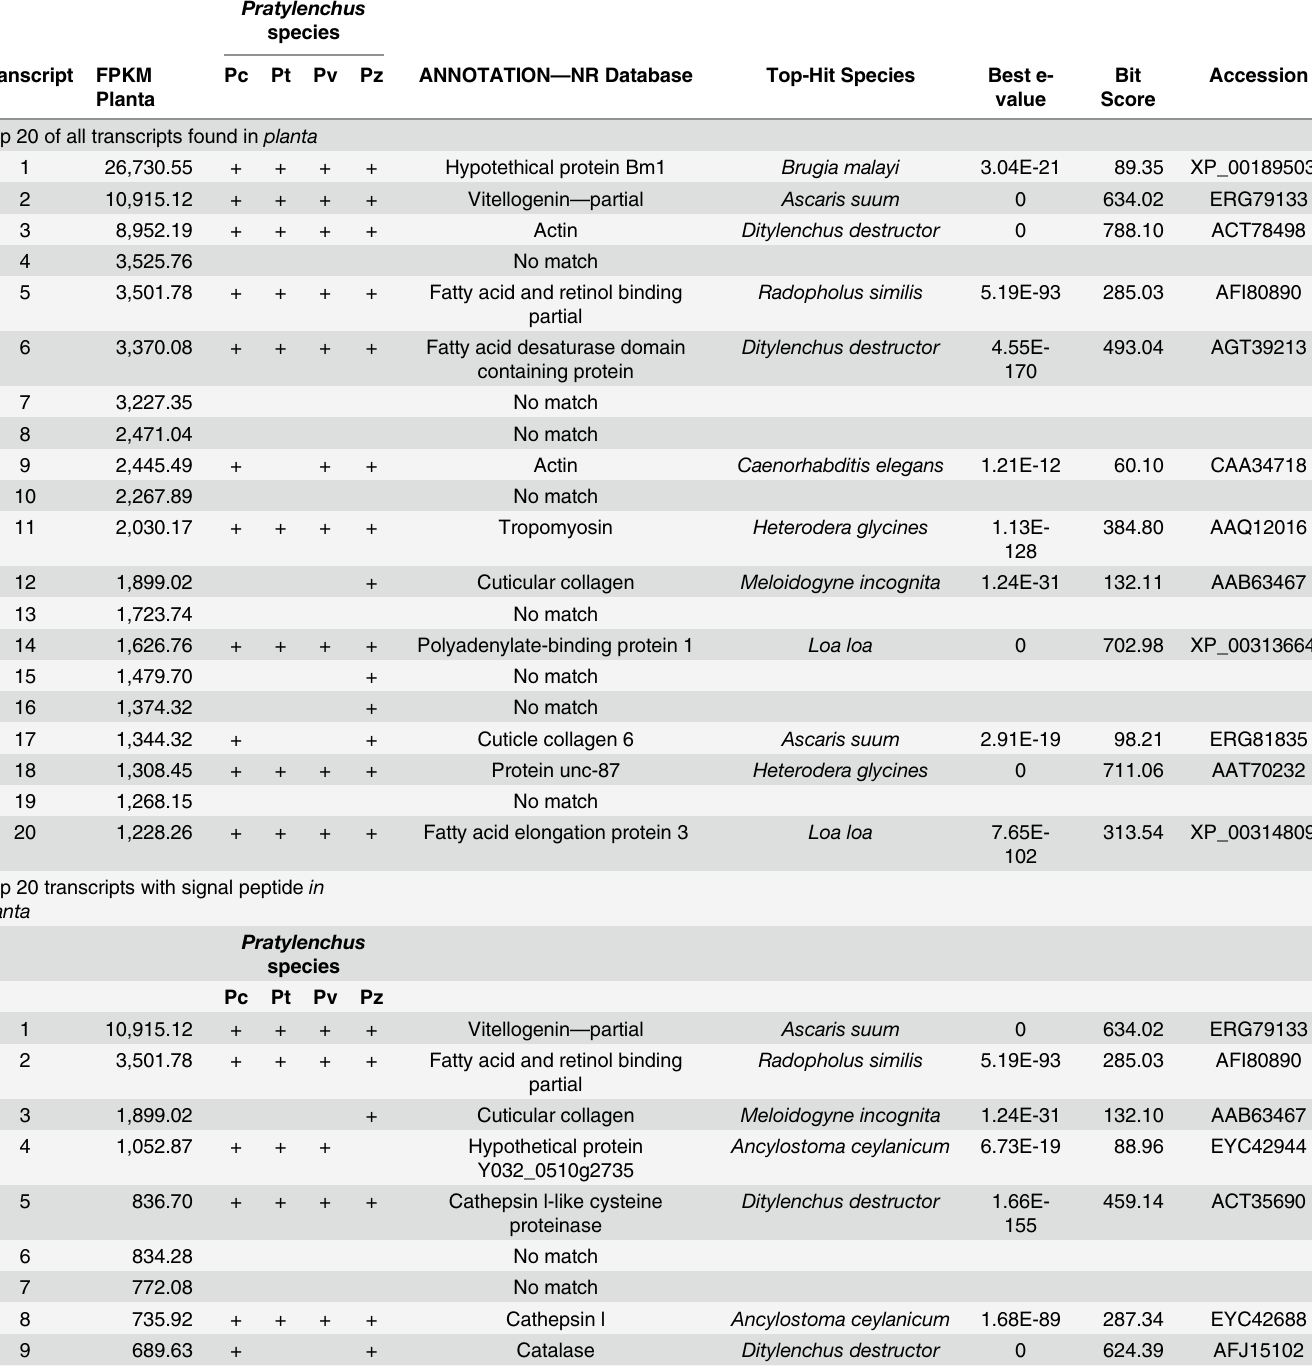
Table 5. List of the top 20 most abundant Pratylenchus penetrans transcripts identified in nematode infected soybean roots (top), the top 20 most abundant P . penetrans transcripts identified in nematode infected soybean roots which encode a putative signal peptide